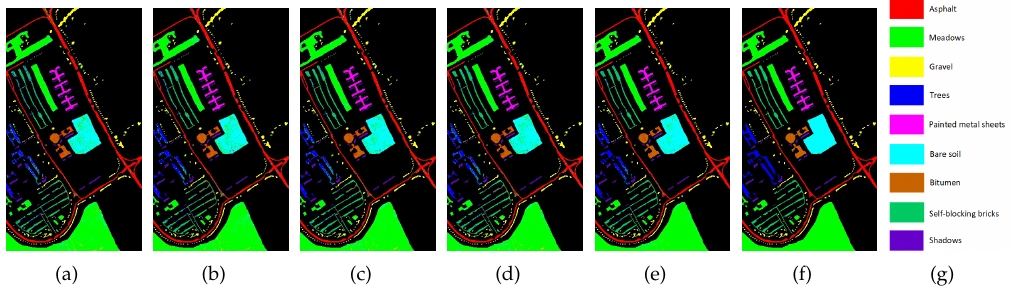
Figure 7. Classification maps for the PaviaU data set obtained by different methods: ( a ) PCA; ( b ) ORF; ( c ) ORF-K-Means; ( d ) ORF-BIRCH; ( e ) PRF. In addition, ( f ) is the ground truth, and ( g ) is the legend.